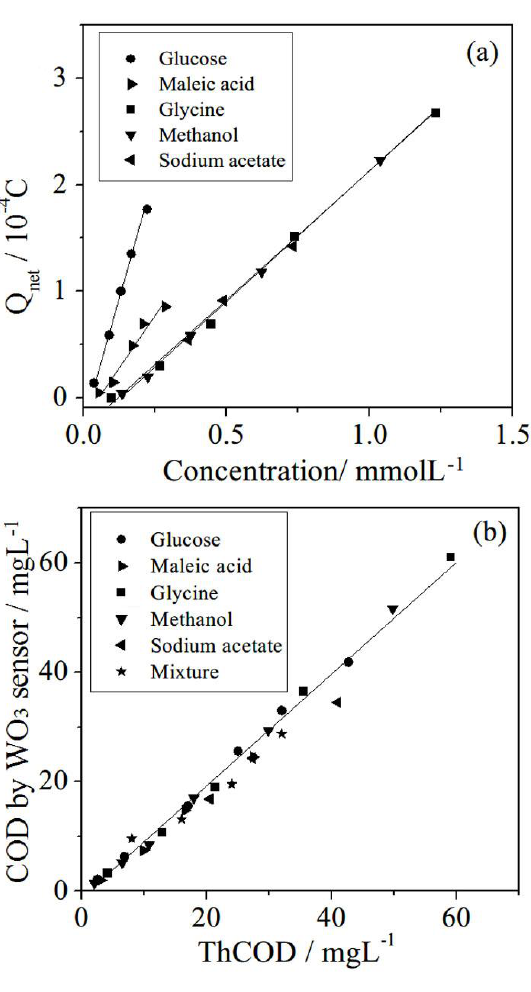
Figure 9. COD determination using a WO /W nanopores sensor: ( a ) quantitative relationship 3 between Q and the concentration of organic compounds; ( b ) The relationship between net COD determined by the WO sensor and the theoretical COD 3